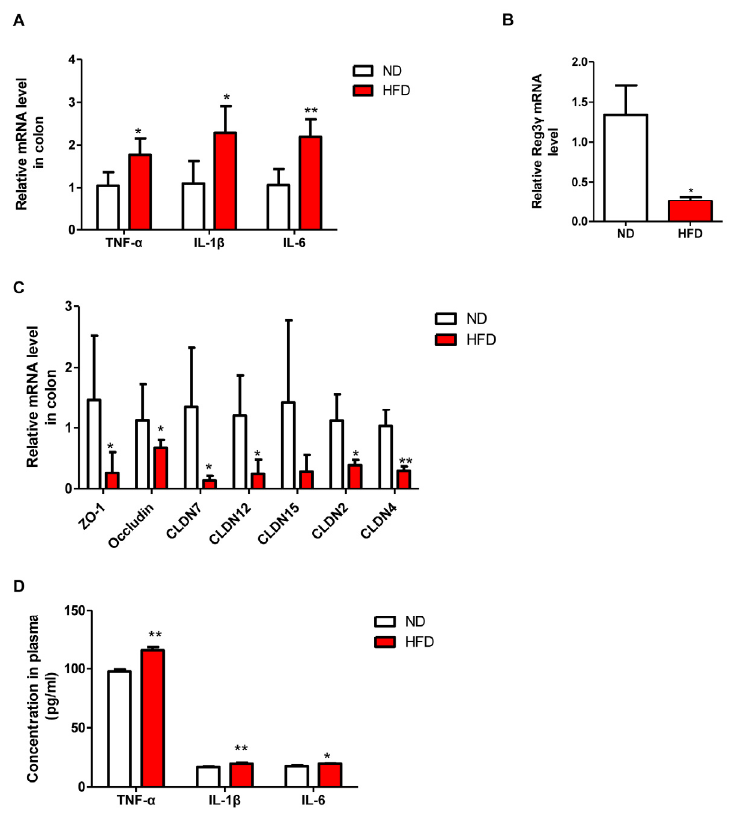
Figure 8. Effect of long-term HFD consumption on the expression of markers involved in inflammation and tight junction in colon. The mRNA levels of inflammation-related genes ( A ), the mRNA level of Reg3 γ ( B ), the mRNA levels of tight junction-related genes ( C ). Levels of inflammatory cytokines in plasma ( D ). CLDN, claudin. Values are shown as the mean ± SEM. t -test was performed. * p < 0.05; ** p < 0.01.